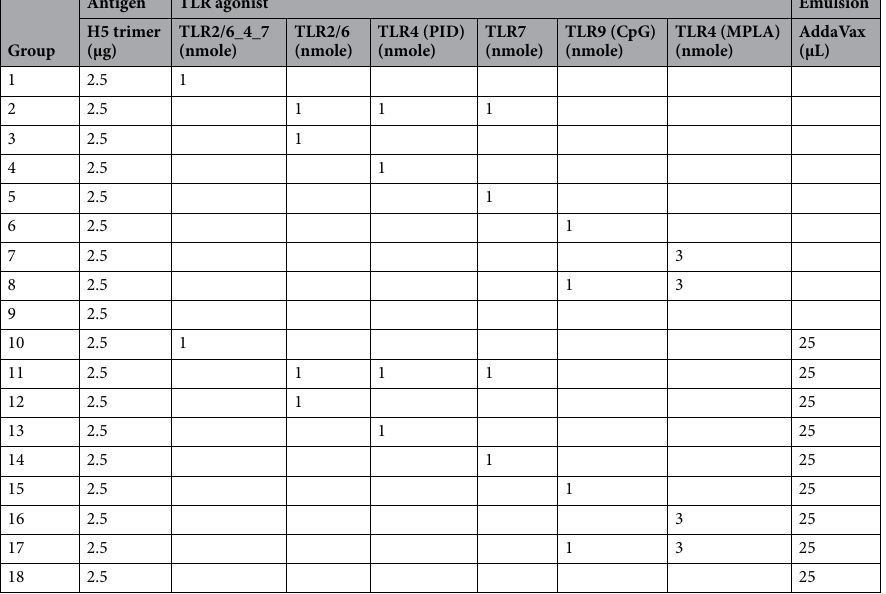
2 mixture. Mice were weighed and monitored daily for the first two weeks for any changes in behavior or appearance and periodically thereafter. Blood was collected into heparinized microcapillary tubes at regular time points (d0, d10, d28, d43) by facial vein bleed under anesthesia with inhaled isofluorane/O 2 and at the experimental endpoint (d103) by cardiac puncture under terminal anesthesia. Tissues (spleens, lymph nodes) were harvested post-mortem for T cell recall assays. For intranasal immunizations (i.n.), vaccine formulations containing 2.5 μg trimerized H5 were administered in a total volume of 20 μL using a micropipette pipette to the right-side nares of mice transiently anesthetized in an isofluorane/O 2 mixture. These mice were boosted via the same route and dose on d56 and lung and nasal washes collected 13 days later. Protein microarrays. HA protein microarrays were fabricated as previously described 27 . Briefly, purified influenza HAs spanning 18 influenza A virus subtypes expressed in human or insect cells as either HA0 or HA1 molecules, were purchased from Sino Biological Inc. (Beijing, China). Each lyophilized antigen was reconstituted to a concentration of 0.1 mg/mL in phosphate-buffered saline (PBS) with 0.001% Tween 20 (T-PBS) and printed onto nitrocellulose-coated glass AVID slides (Grace Bio-Labs, Inc., Bend, OR, USA) using an Omni Grid 100